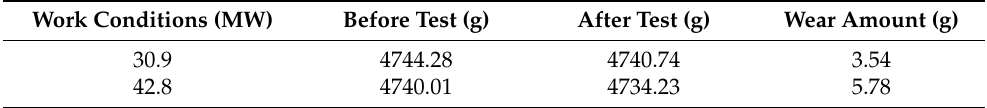
Figure 18. ( a – d ) Wear amount at different scoring points. Table 5. Weighing of guide vane specimens before and after wear (Tungsten Carbide